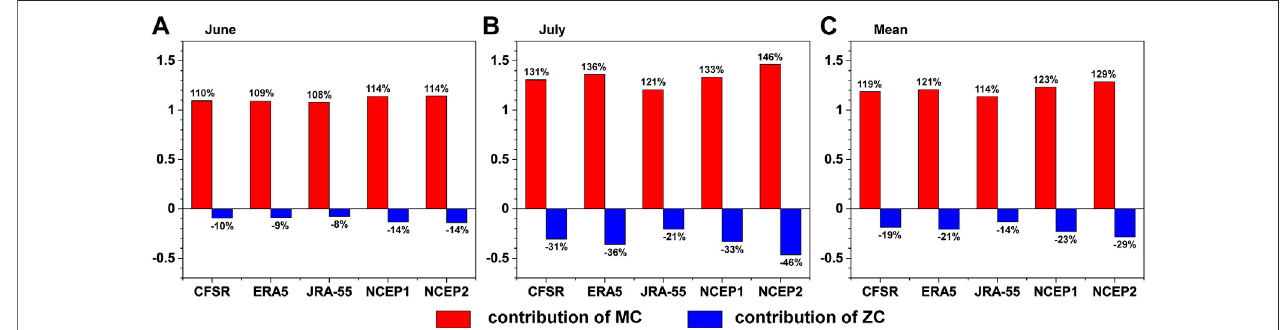
FIGURE3| ContributionsoftheMC(redbars)andZC(bluebars)totheanomalousverticalvelocityofthewesternpartoftheWPSHat500 hPain (A) June, (B) July, and (C) the mean of June and July 2020 based on the 3P-DGAC method derived from the CFSR, ERA5, JRA-55, NCEP1, and NCEP2 reanalysis data sets. The quantitative contributions are shown at the top of each